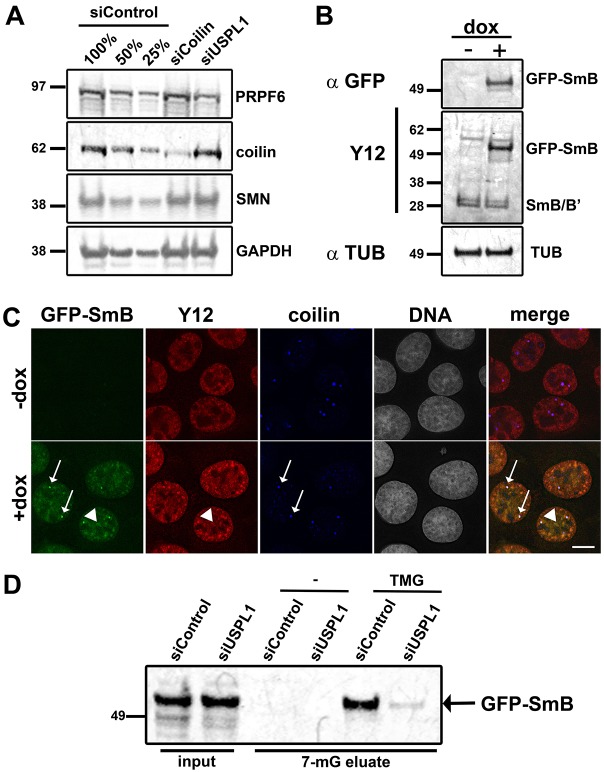
Defects in snRNP production upon USPL1 knockdown. (A) Total cell lysates of siRNA-treated U2OS cells were analysed by immunoblotting using antibodies as indicated. Different amounts of control lysate (100%, 50%, 25%) provide an internal standard for protein levels. Similar effects were observed with HeLa cells (data not shown). (B) Immunoblot of total cell lysate of U2OS GFP–SmB cells without (−dox) or 18 hours after (+dox) induction using the Y12 or an anti-GFP antibody showing expression of GFP–SmB at its expected molecular mass. Alpha-tubulin (TUB) stain serves as loading control. (C) U2OS GFP–SmB cells were analysed without (−dox) or 18 hours after (+dox) induction for expression and localisation of GFP-SmB by immunostaining using the Y12 and anti coilin antibody as marker for nuclear speckles (arrowheads) and Cajal bodies (arrows), respectively. Scale bar: 10 µm. (D) Formation of nascent snRNPs was analysed by TMG immunoprecipitation in siRNA-treated U2OS GFP–SmB cells. Empty Protein-G–agarose beads (-) serve as a control. Bound proteins were eluted from the beads using 25 mM 7-methylguanosine (7-mG) and analysed for the presence of GFP–SmB by immunoblotting for GFP. Input corresponds to 0.75% of the material used in the immunoprecipitation.